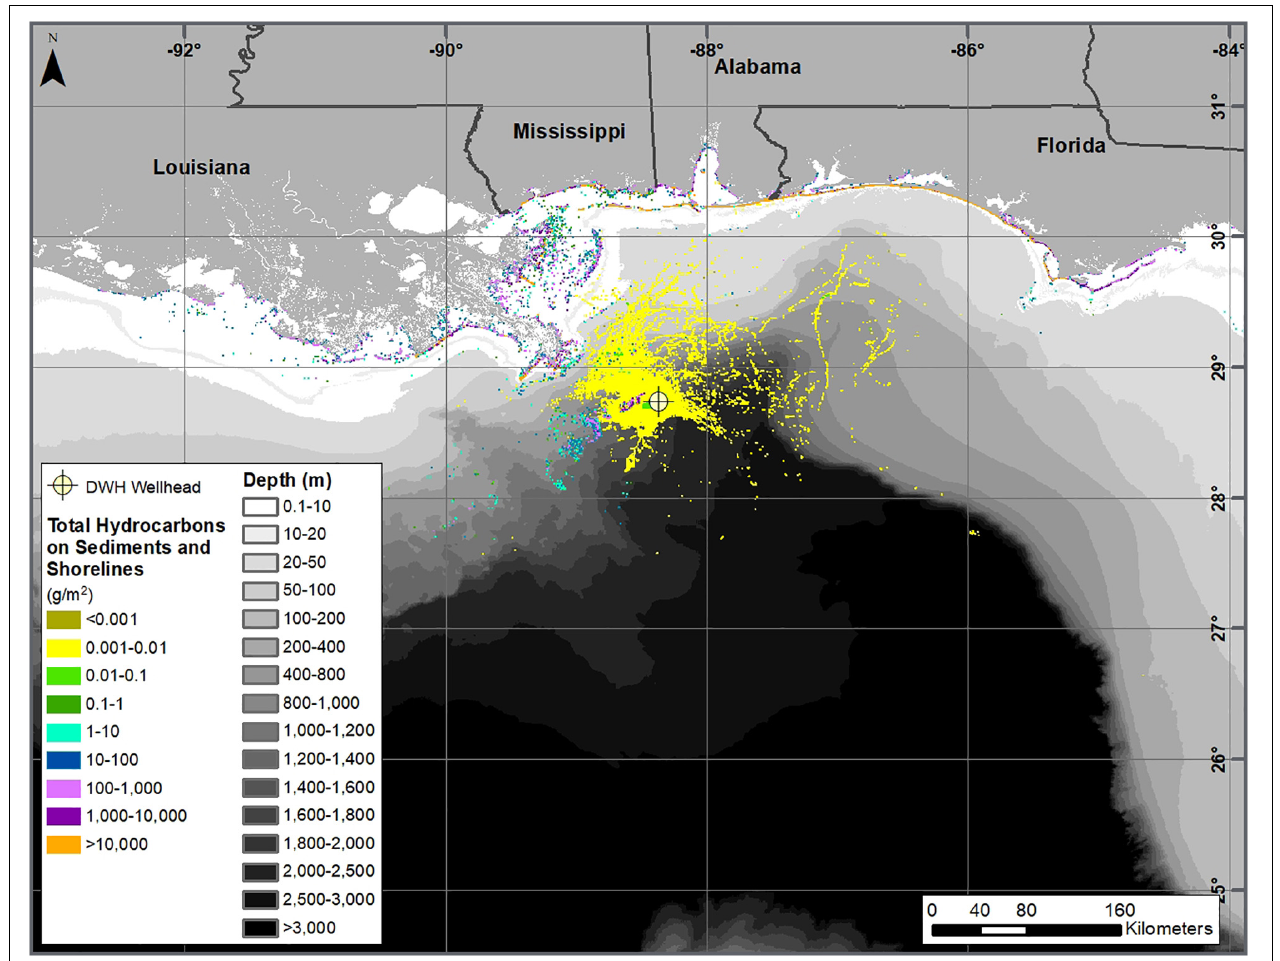
FIGURE 9 | Cumulative amount of oil coming ashore and settling to sediments (in g/m 2 ) by August 31, 2010 for the base case simulation using HYCOM-FSU currents and NARR